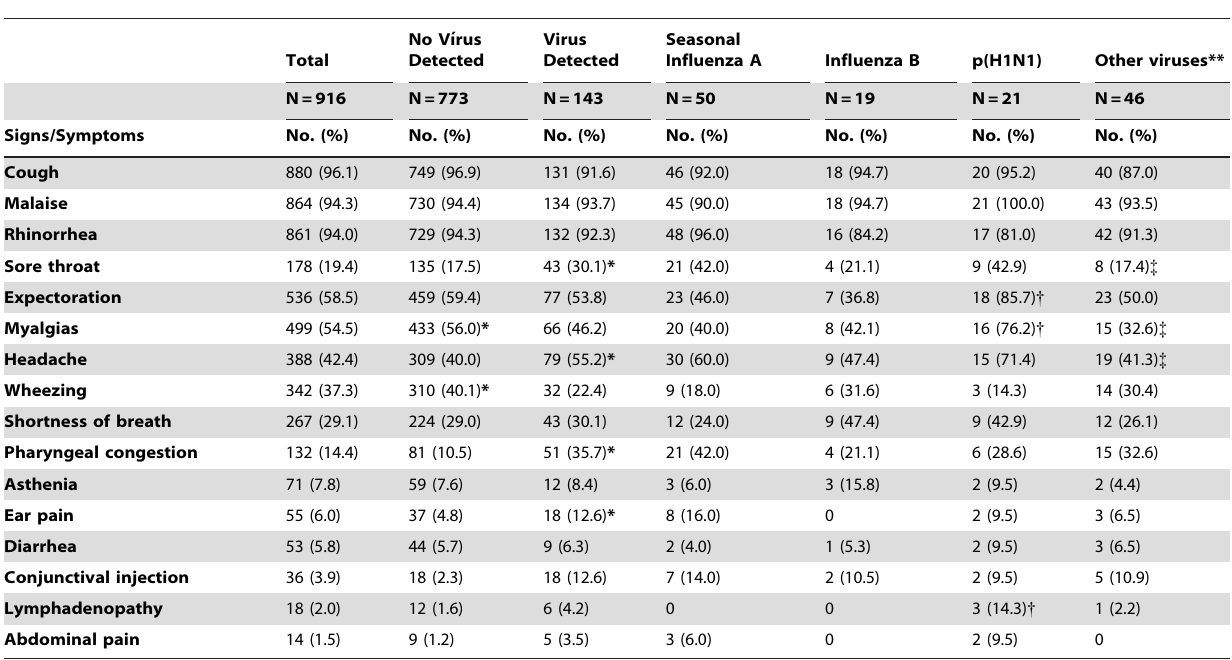
Table 3. Signs and symptoms of patients with acute febrile respiratory infections detected by virus identified in two health centers of Maracay, Venezuela: October 2006–December